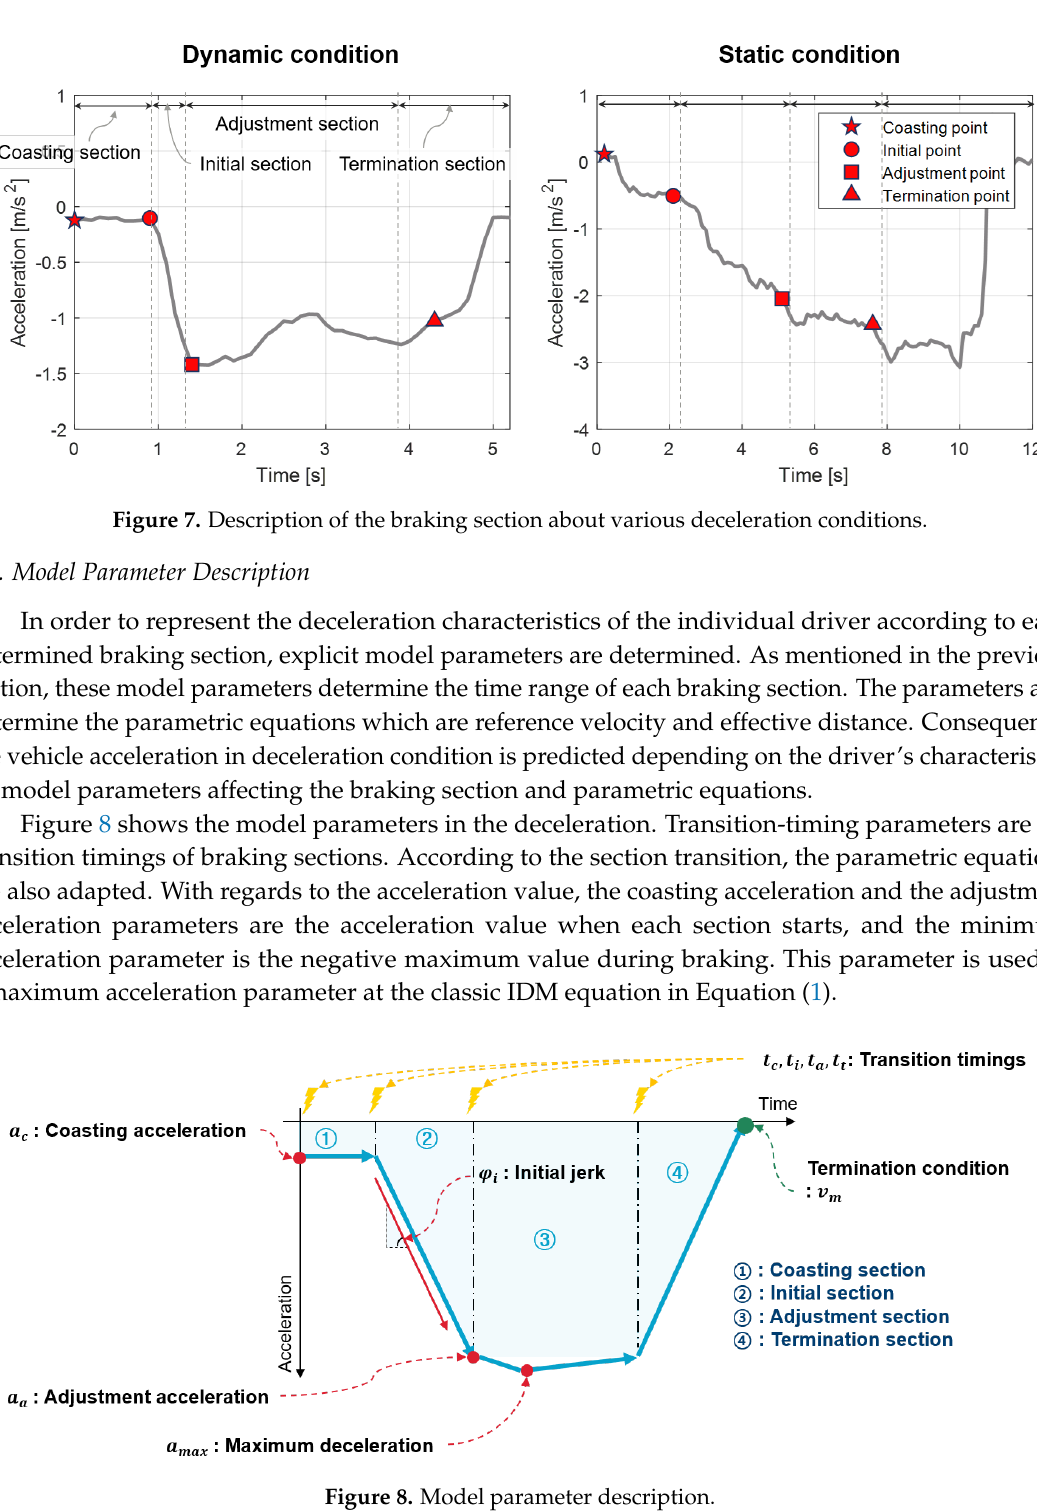
Figure 8. Model parameter